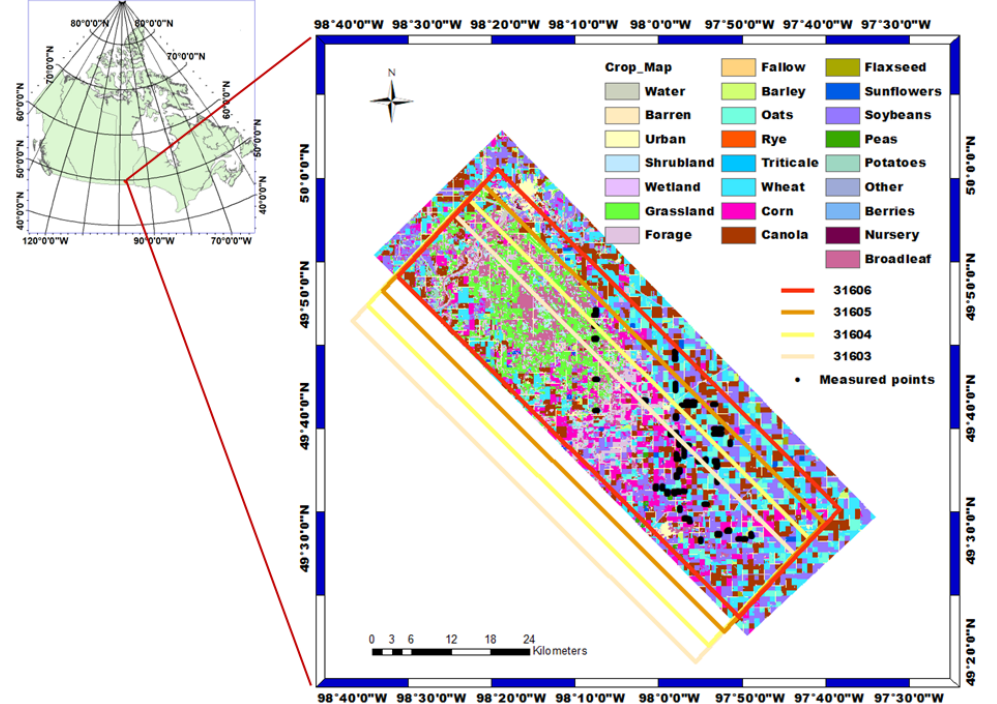
Figure 1. The map of the geographical location of the experimental area, vegetation classification map, coverage of the four flights, and in situ SSM measurement